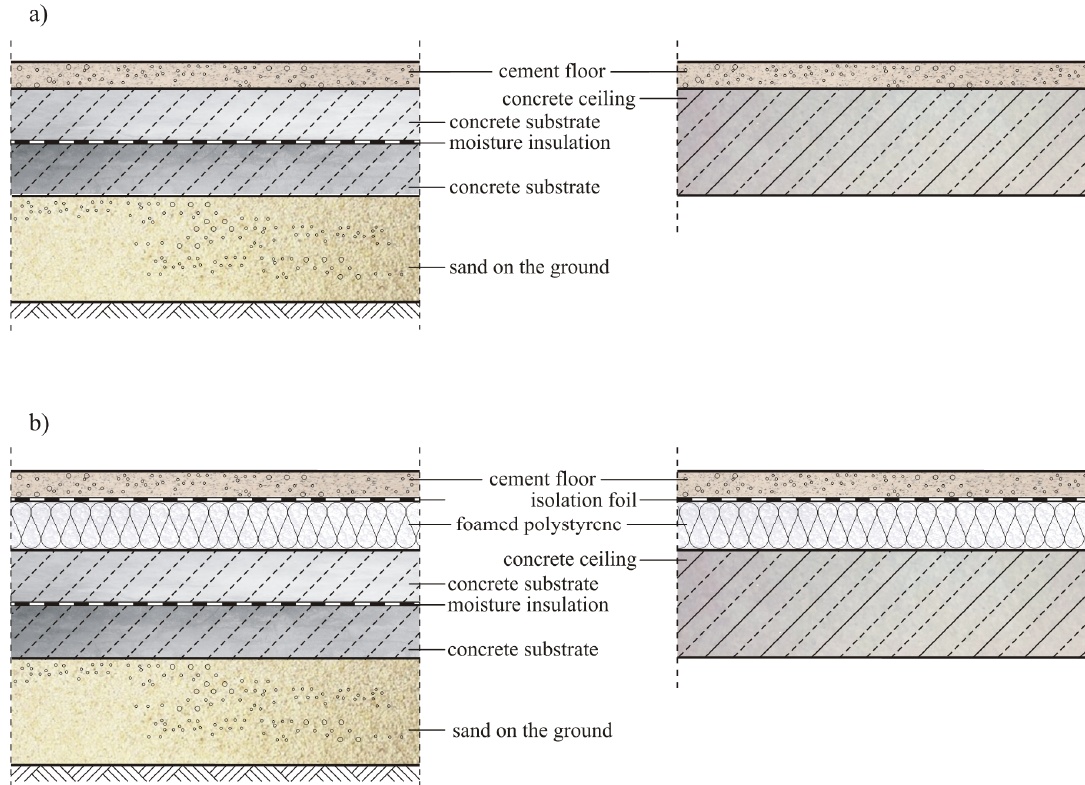
Figure 1. Applied variants of various floor systems made on: ( a ) a concrete substrate or a reinforced concrete ceiling: ( b ) a foamed polystyrene laid on a concrete substrate or reinforced concrete ceiling.